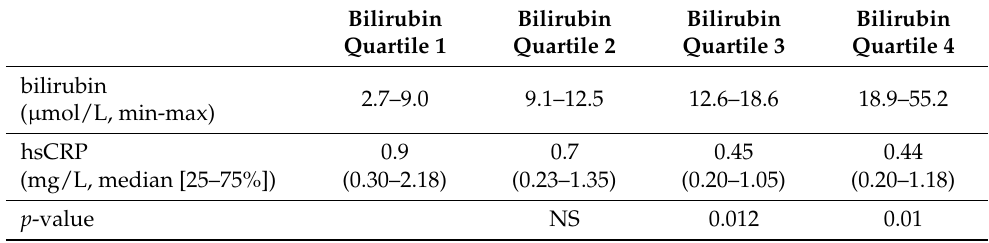
Table 6. Relationship between serum bilirubin concentration and hsCRP in healthy controls.